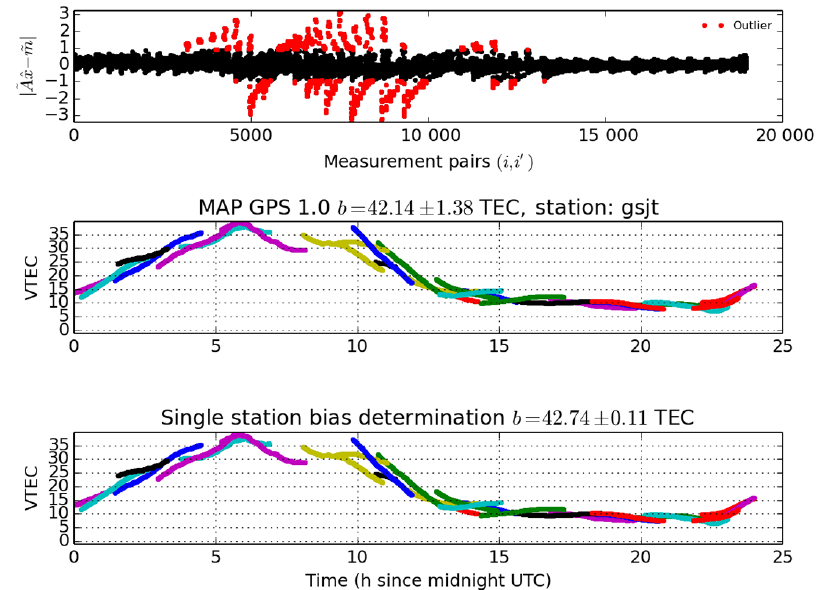
Figure 2. Bias estimation using time differences of measurements obtained with a single receiver. Top panel shows the residuals of the maximum likelihood fit to the data. The points shown with red are automatically determined as outliers and not used for determining the receiver bias. These mostly occur during daytime at low elevations. The center panel shows vertical TEC estimated with the original MAPGPS receiver bias determination algorithm, while the bottom panel shows vertical TEC measurements obtained using only time differences using the new method described in this paper, assuming constant receiver bias and known satellite bias. The VTEC results do not differ significantly.